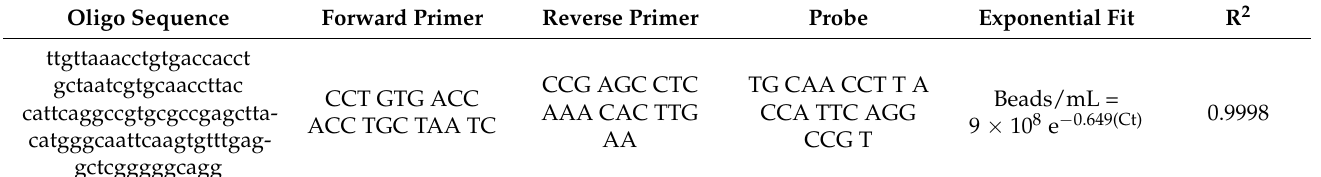
Table 1. Properties of DNA oligo attached to PSL beads.